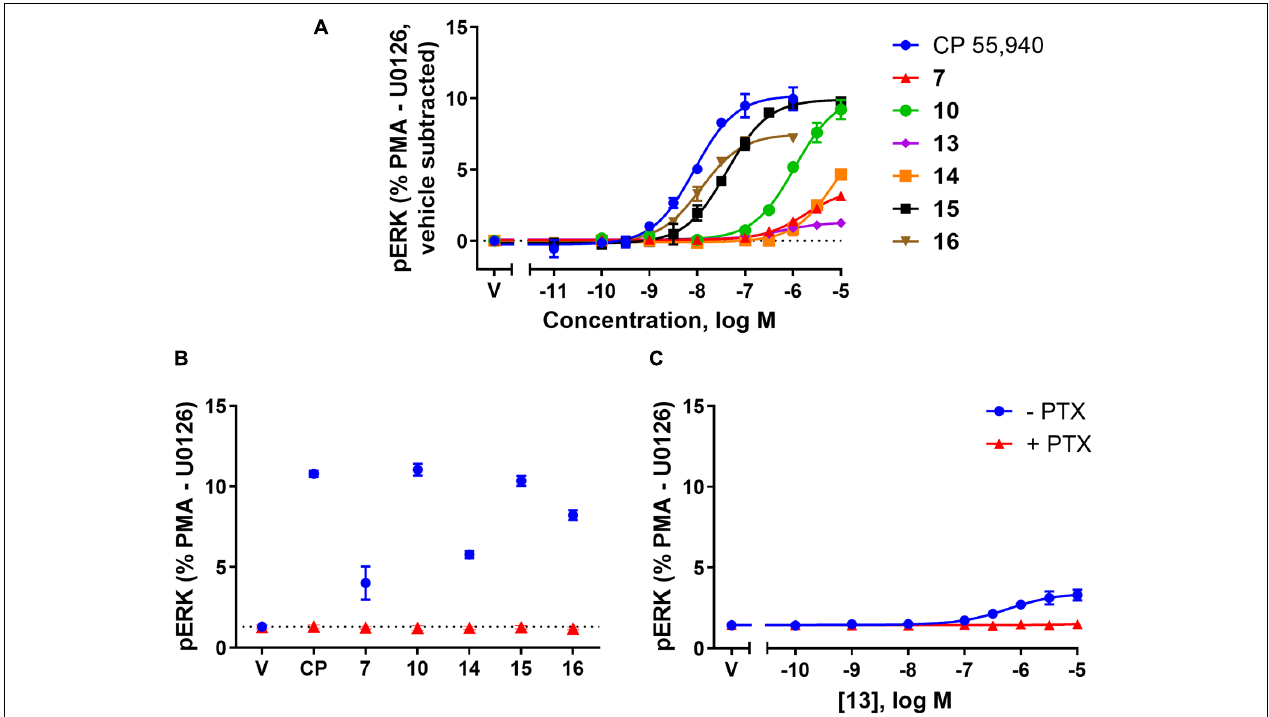
FIGURE 4 | pERK activation via hCB 2 in response to CP 55,940 and 2,4,6-trisubstituted 1,3,5-triazines. ERK1/2 phosphorylation (pERK) at 4 min post-drug addition in HEK Flp-in hCB 2 cells. (A) Concentration-response curves for CP 55,940 and all test compounds. (V, vehicle) (B) Response at a single concentration (1 µ M for CP 55,940 and 16 , 10 µ M for others) following 27–28 h pre-treatment in the absence or presence of PTX (CP, CP 55,940). Dotted line indicates average vehicle (V) response. (C) Concentration-response curve for 13 following 27–28 h pre-treatment in the absence or presence of PTX. Data in all panels are presented as mean ± SEM from three independent experiments, and normalised to U0126 (0%) and PMA (100%). In panel (A) the vehicle response in each experiment was then subtracted such that the vehicle condition is represented as 0%.